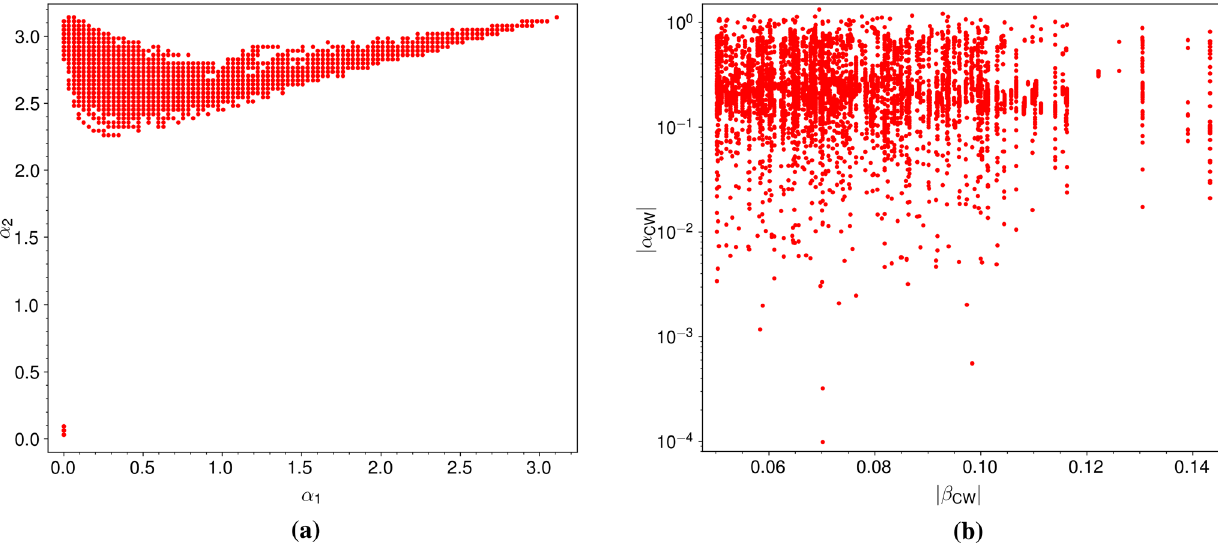
Fig. 5 Values of the CPV phases α 1 , 2 ( a ) and Coleman–Weinberg parameters | α CW | and | β CW | for the points of our ML σ M parameter scan. The electron EDM was required to be in the range | d e / e | = ( 0 . 5 − 1 . 1 ) × 10 − 29